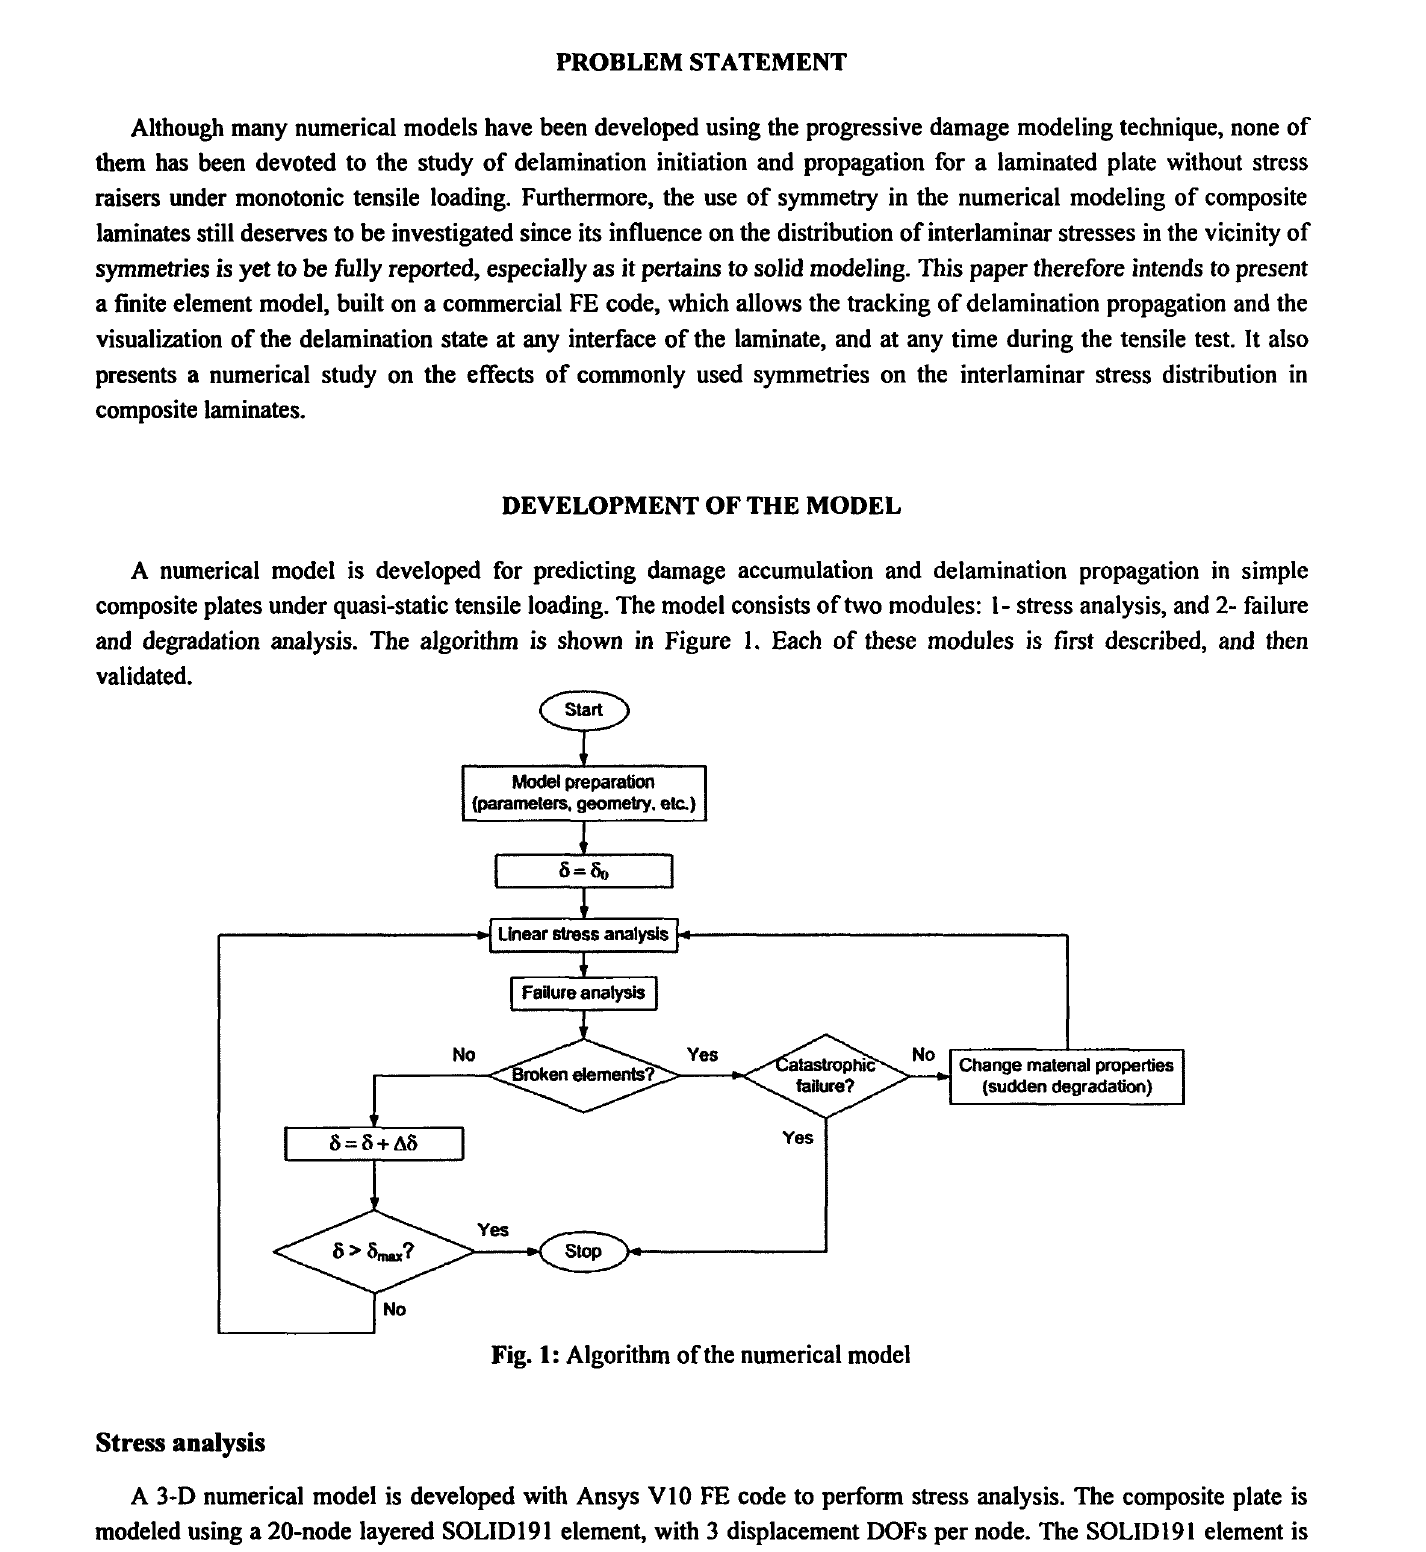
Fig. 1: Algorithm of the numerical